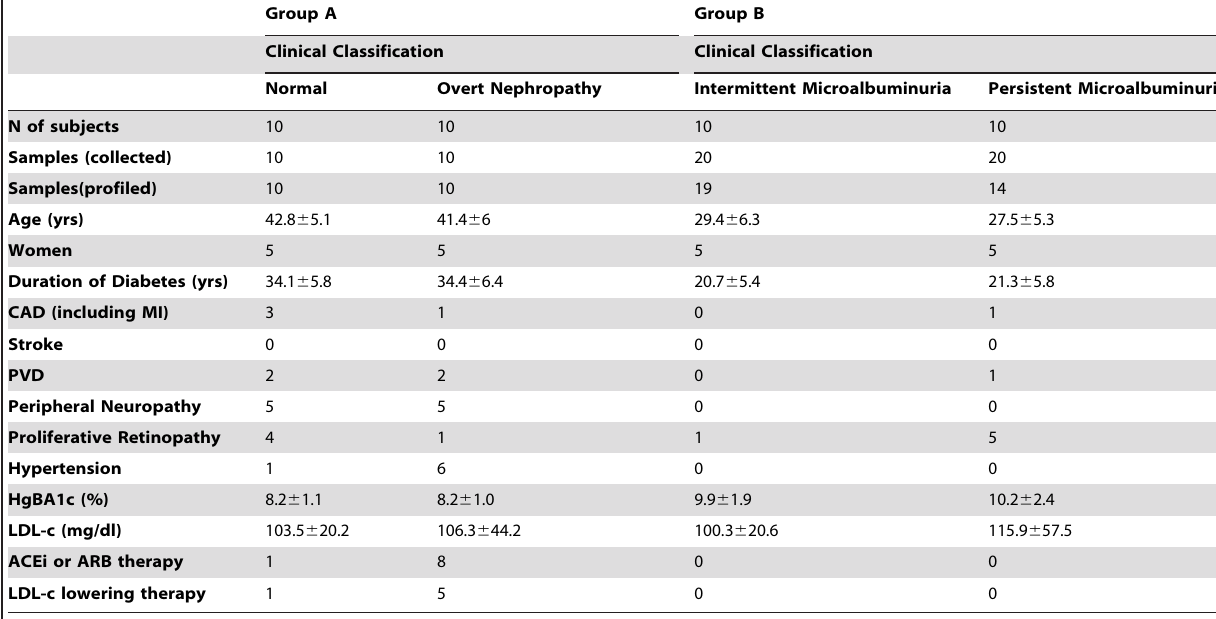
Table 1. Patient